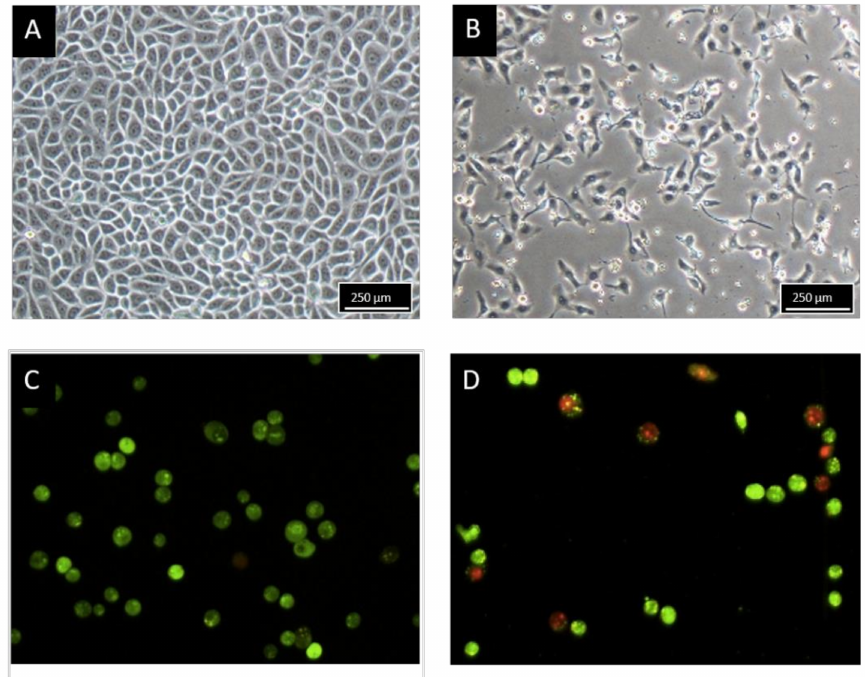
Figure 1. Morphological changes of MCF 7 cells viewed under light microscope after exposure to: ( A ) Untreated, ( B ) 8.2 µ M of BHMC for 48 h. Fluorescent microscopy of acridine orange and propidium iodide dual staining of human breast cancer cells lines (MCF-7) ( C ) untreated and ( D ) 8.2 µ M of BHMC for 48 h. Note: Figures shown were representative of one of at least three independent replicates with similar parameter (magnification 100 ×